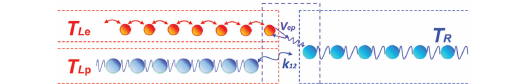
Frontiers in Energy Research |